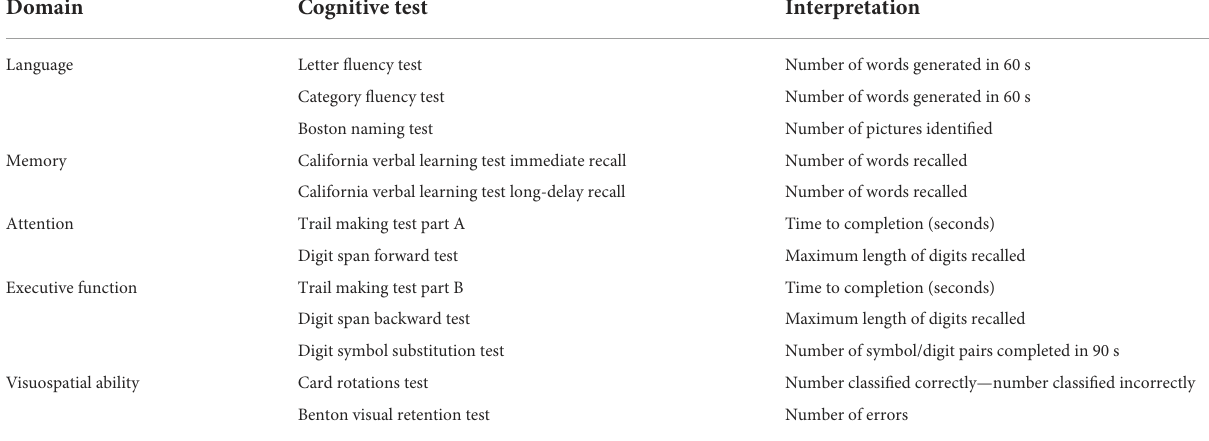
TABLE 1 Description of the cognitive tests in the Baltimore Longitudinal Study of Aging